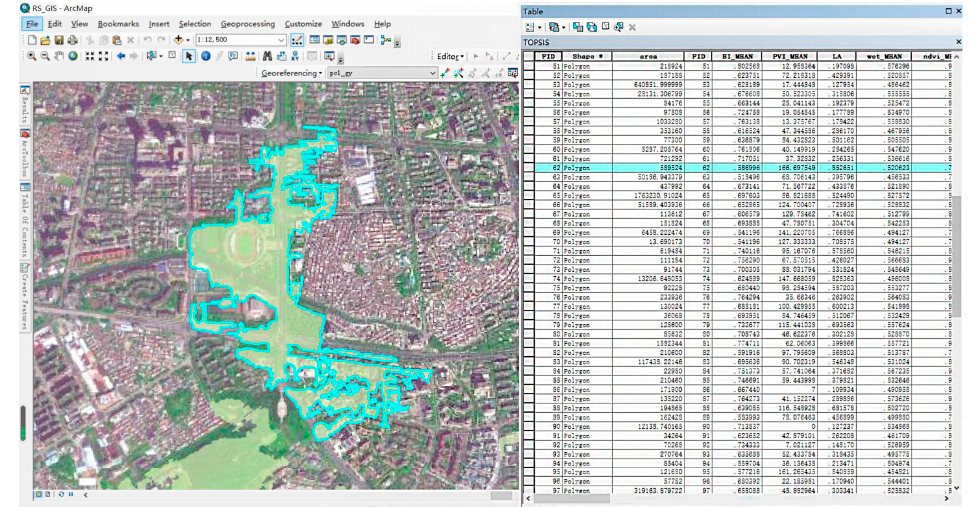
Figure 17. LA information query for a specific UGI patch.